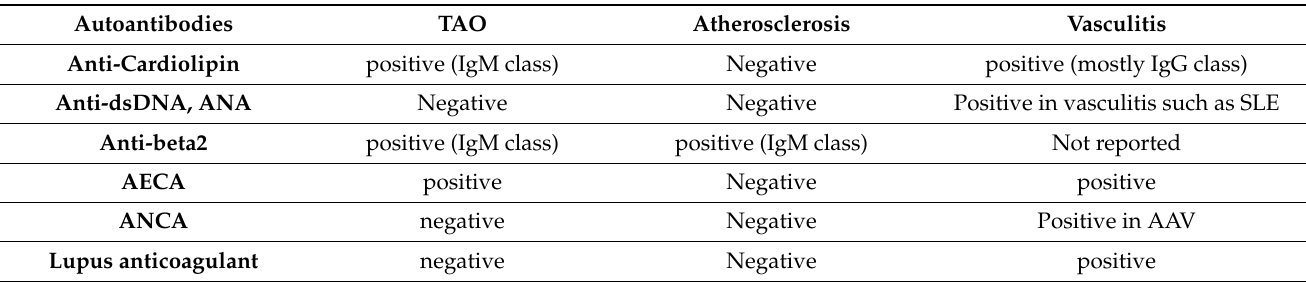
Table 4. Summary of the main findings on